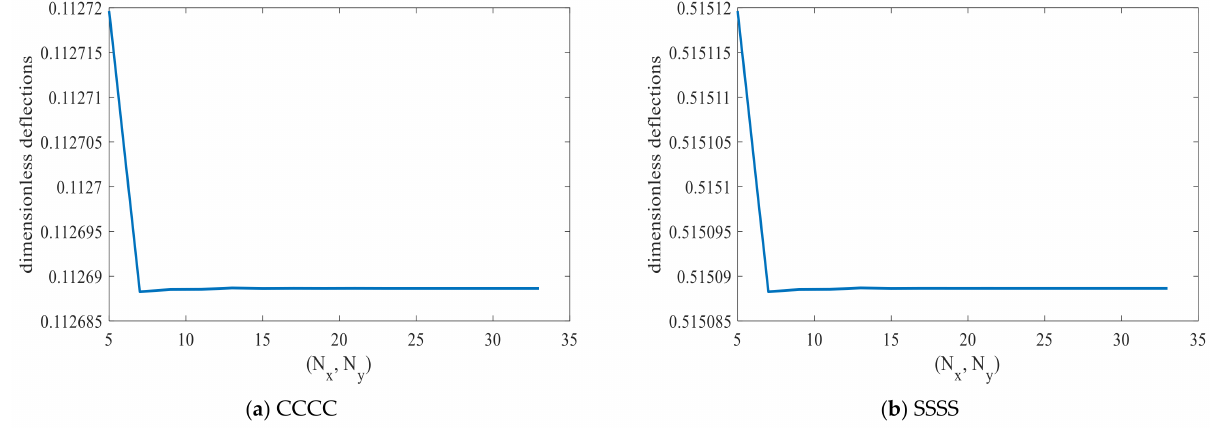
Figure 5. Convergence study of the bending deflection, when assuming a GPL-UD, p 0 = 10 5 , b / a = 5, a / h = 10, and Λ = 0.5%: ( a ) CCCC boundary conditions, ( b ) SSSS boundary conditions. GPL Table 2. Dimensionless natural frequency of a rectangular plate made by pure epoxy and dif- ferent types of graphene distribution with various longitudinal and transverse mode shapes